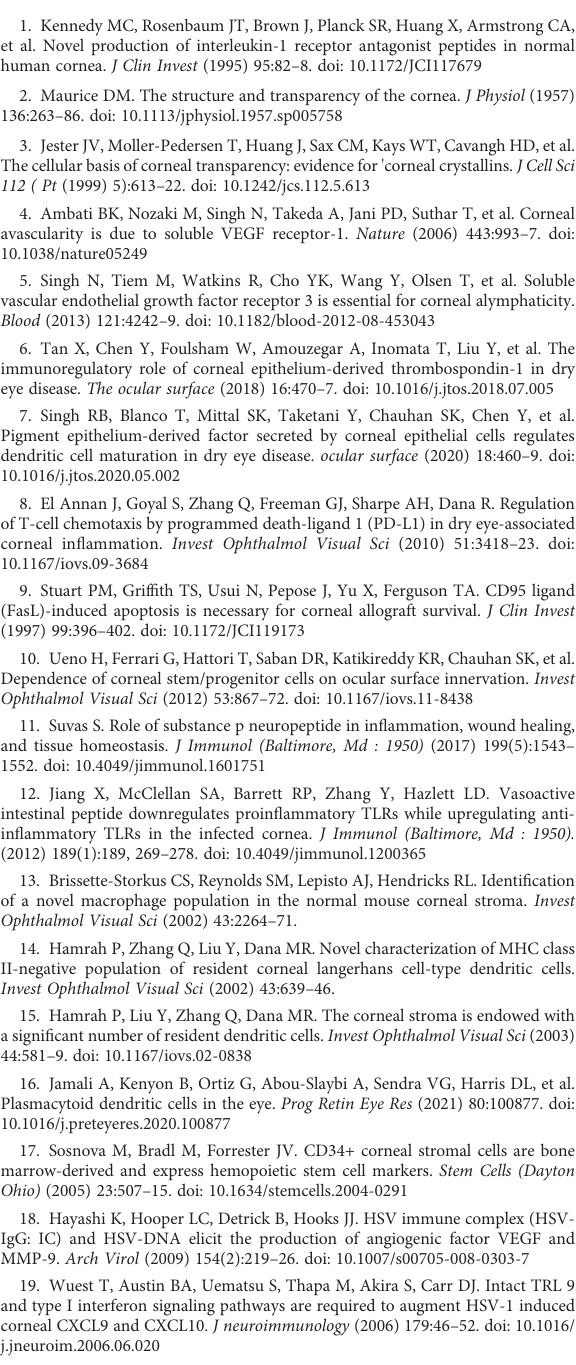
g ,andgranzymeBfromWTandOPNKOaredisplayed.Theinnersegment segments display cells expressing different combinations of proteins whereas the outer color-coded arcs around each circle show the frequency of cells expressing each protein (CD107a, IFN- g , and granzyme (B) . The polyfunctionality of the cells is indicated in panel B with the data displayed as mean ±